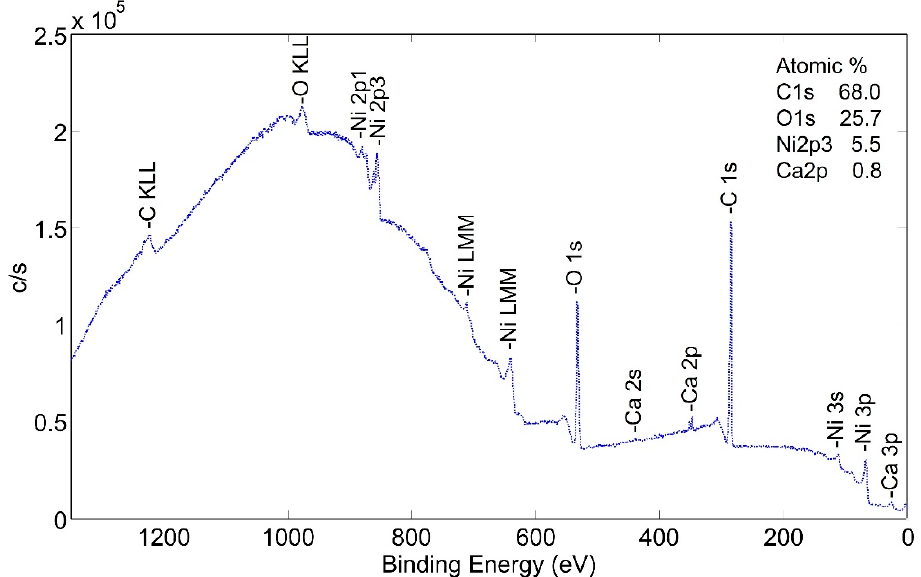
Figure 6. XPS wide scan (low energy) photoemission spectra of non-heat-treated NPG a-sample.